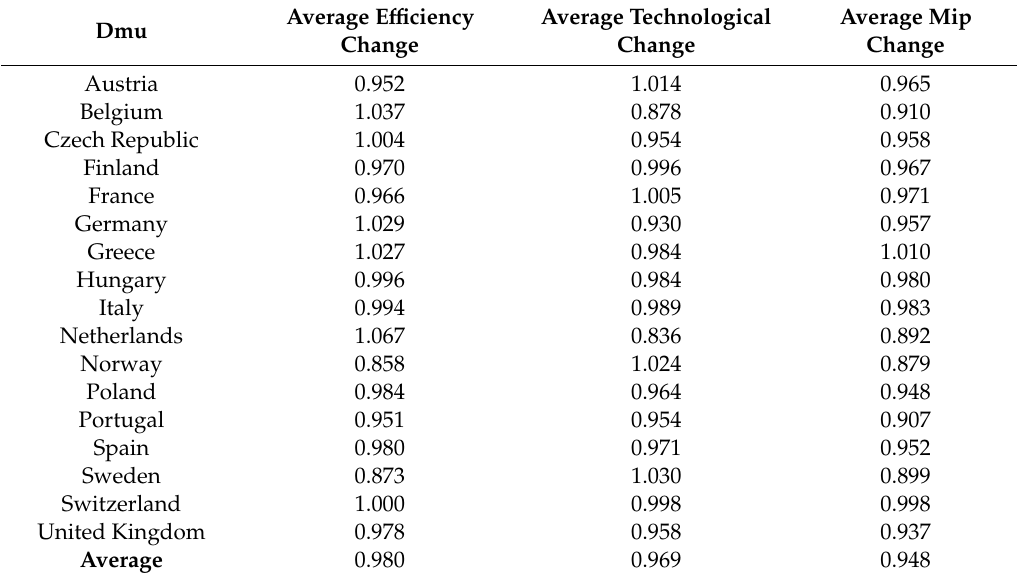
Table 10. Average MPI changes and its components from